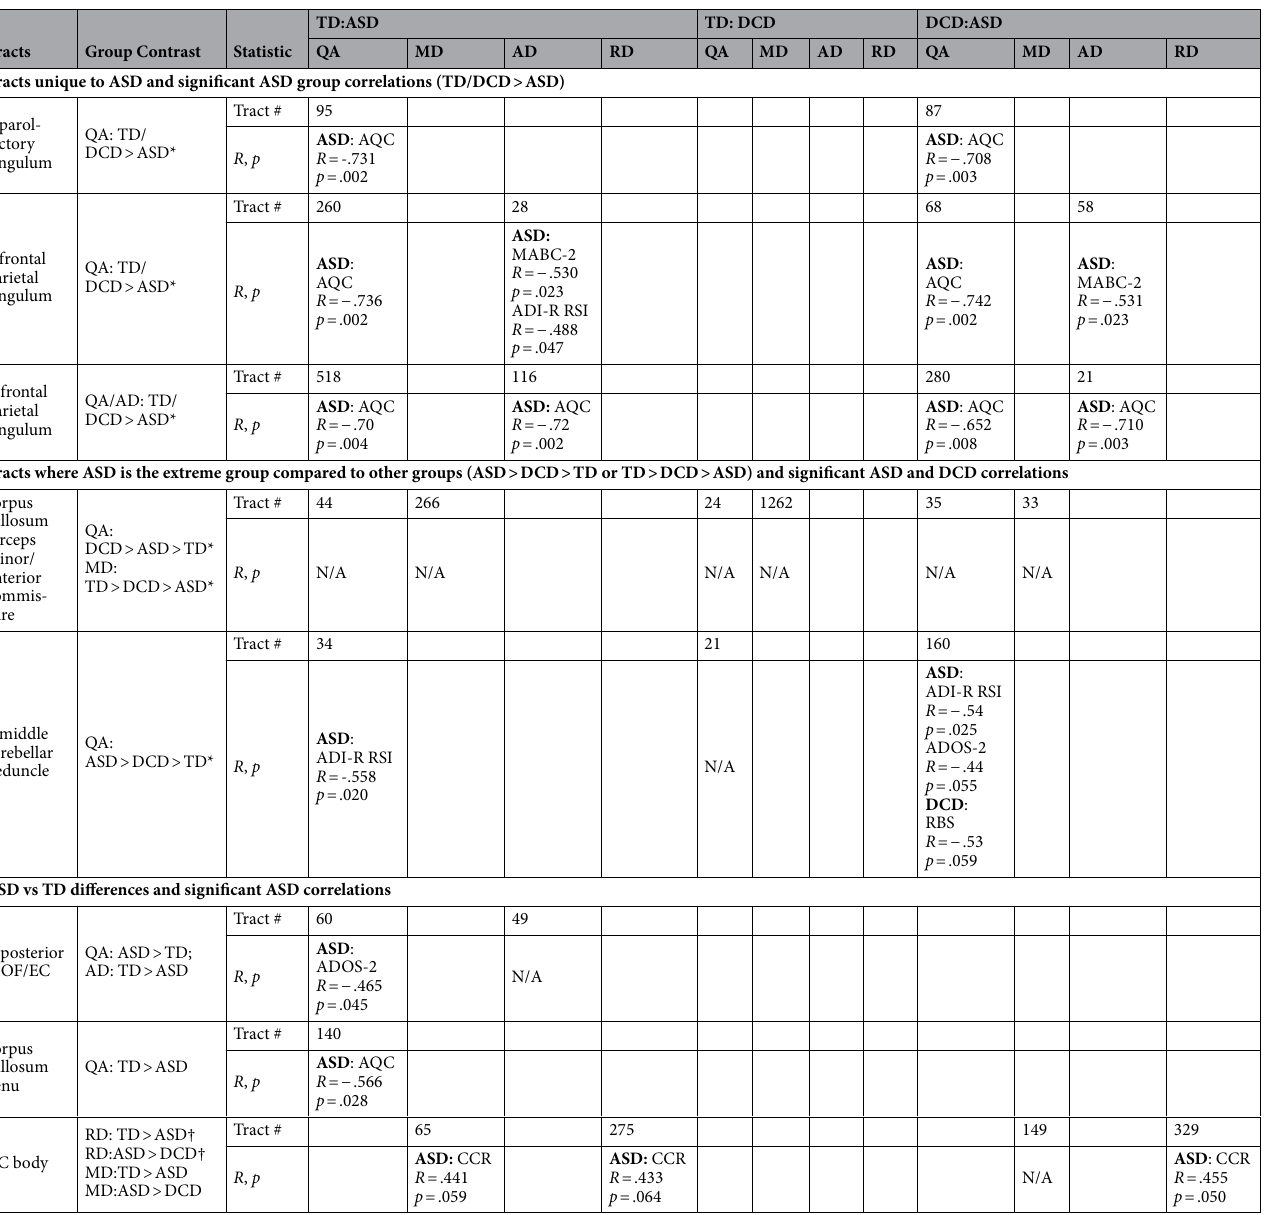
Table 2. Between group whole-brain diffusion differences and correlations with behavior in ASD and/or DCD. * = good-moderate overlap between group comparison tracts, † = moderate overlap between group comparison tracts; p > .05; ASD = autism spectrum disorder; DCD = developmental coordination disorder; TD = typically developing; L = left; R = right; QA = quantitative anisotropy; MD = mean diffusivity; AD = axial diffusivity, and RD = radial diffusivity; AQC = Alexithymia Questionnaire for Children 2-factor Total ; SRS = Social Responsivity Scale-2 Total Score; RBS = Repetitive Behaviors Scale Total Score; SenSOR = Sensory Over-Responsivity Scale Total Score; MABC-2 = Movement Assessment Battery for Children-2 Total Score; CCR = Connors Child Report Total Score; GTC = gesture to command; IMI MF = imitation of meaningful gestures; IMI ML = imitation of meaningless gestures; TU = tool use; ADOS-2 = Autism Diagnostic Observational Scale-2 Comparison Score; ADI-R RSI = Autism Diagnostic Interview Revised, Reciprocal Social Interactions